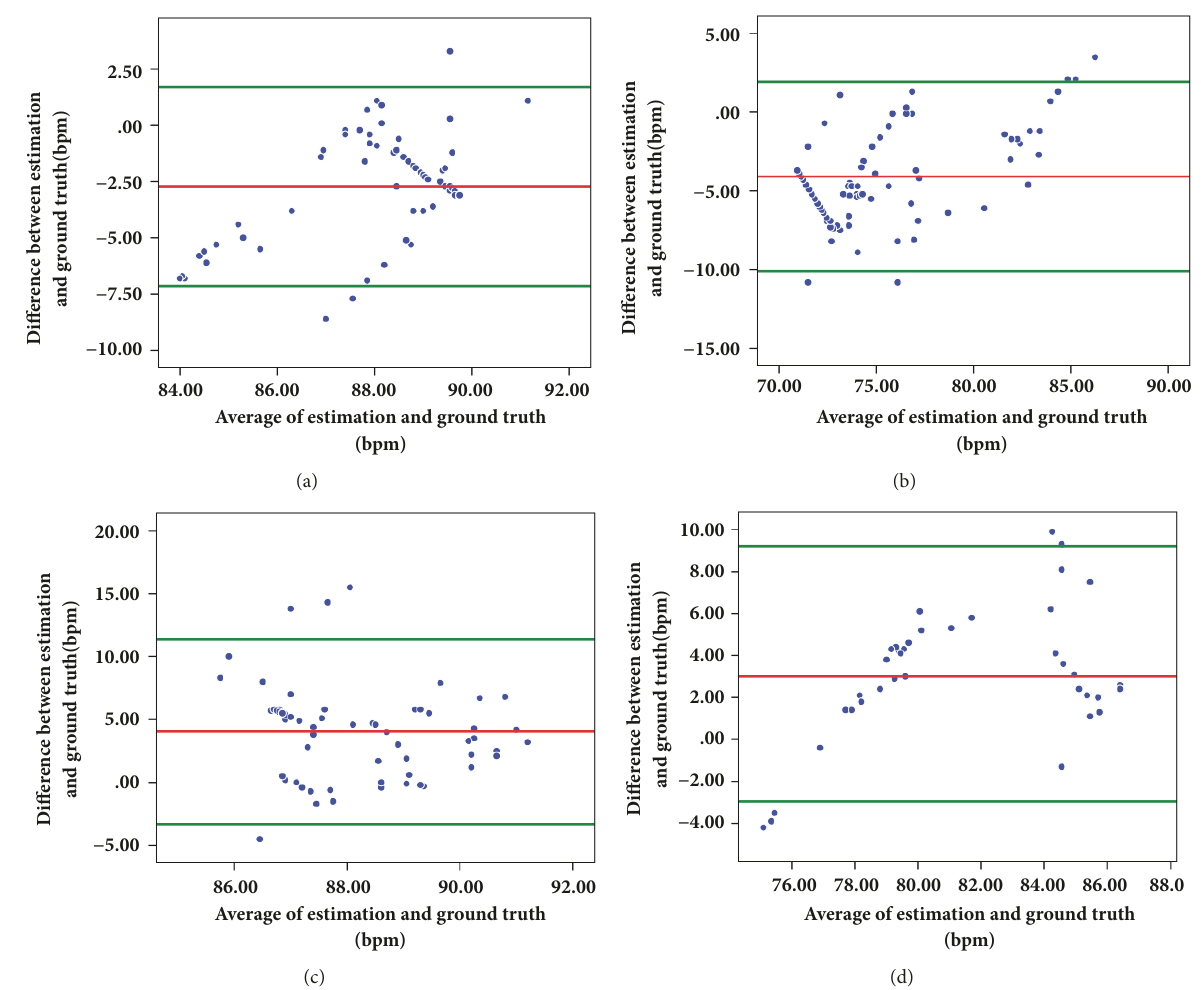
Figure 4: Bland-Altman plot analyzed at a 95% confidence interval. Each agreement of plot: (a) 95.9%; (b) 93.2%; (c) 93.5%; (d) 90%.